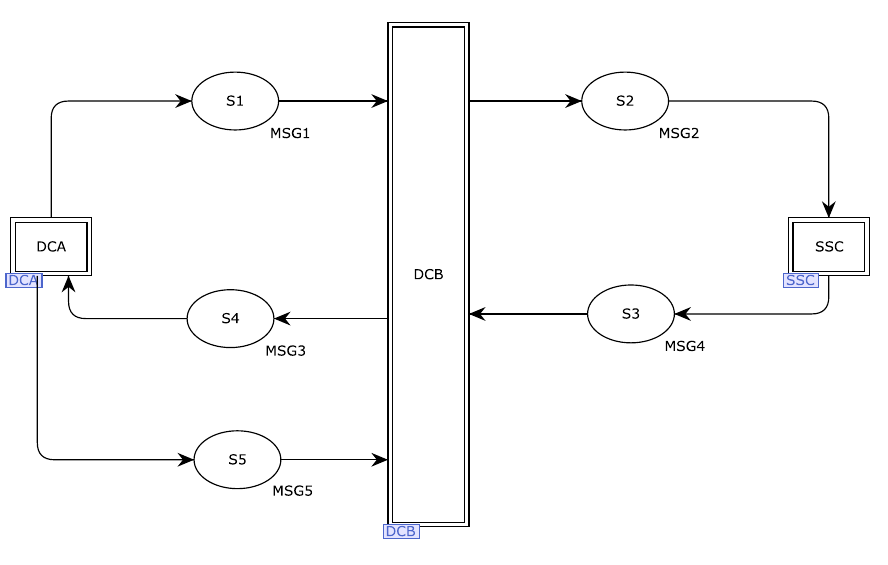
Figure 4. SOME/IP top-level